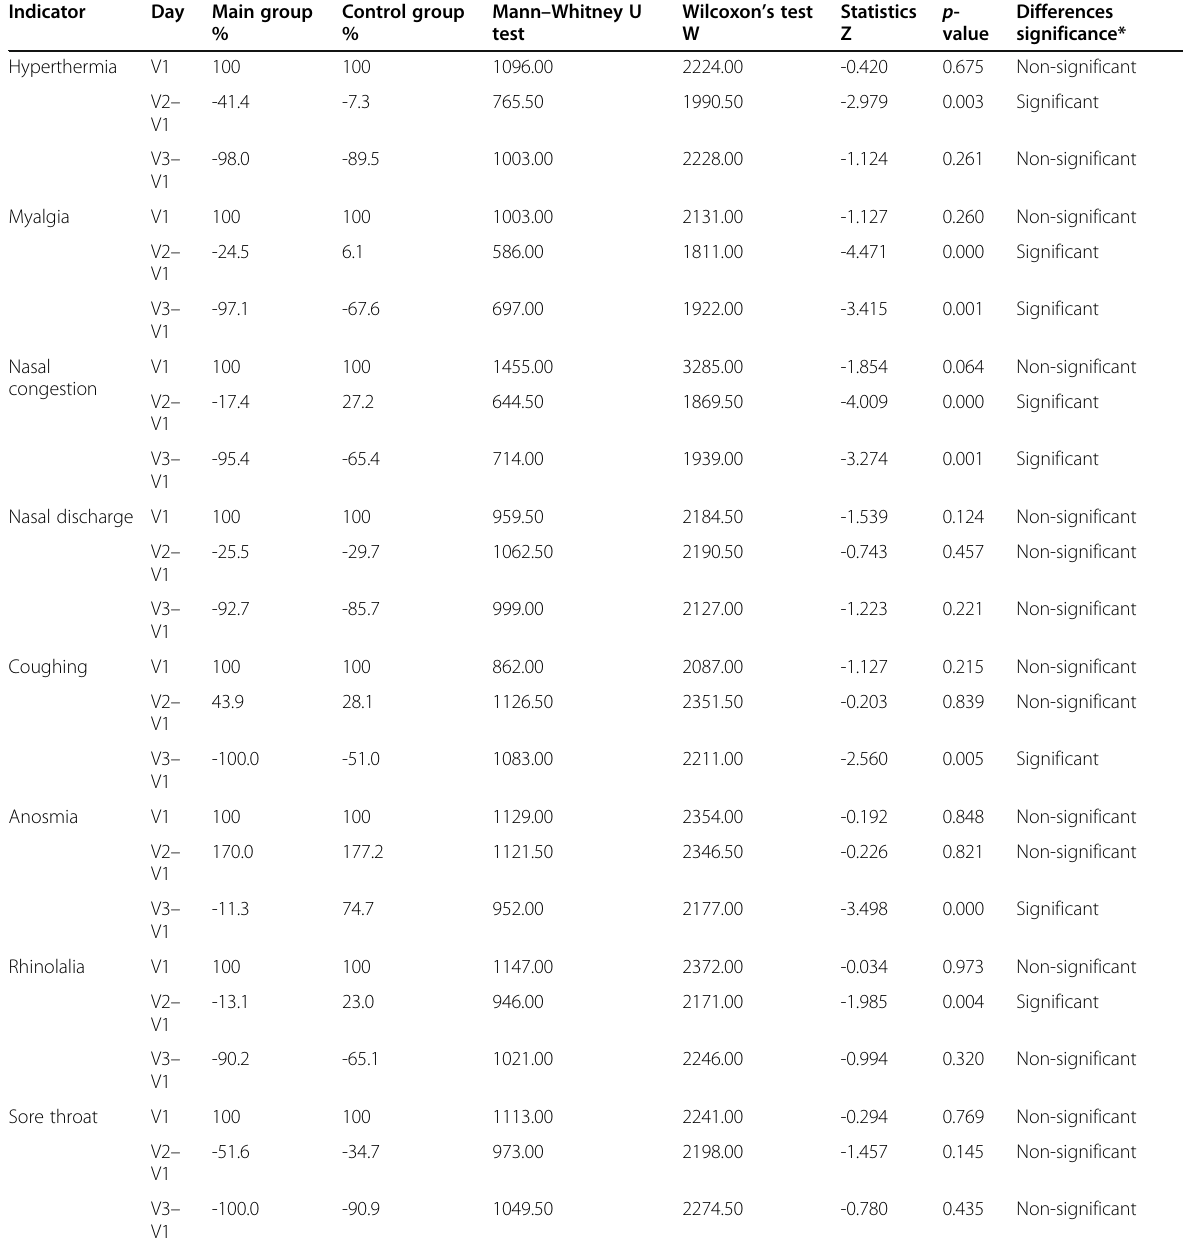
Table 4 Comparison of the groups by the dynamics of the main symptoms severity according to the physician ’ s assessment (% of the Mann-Whitney U test)